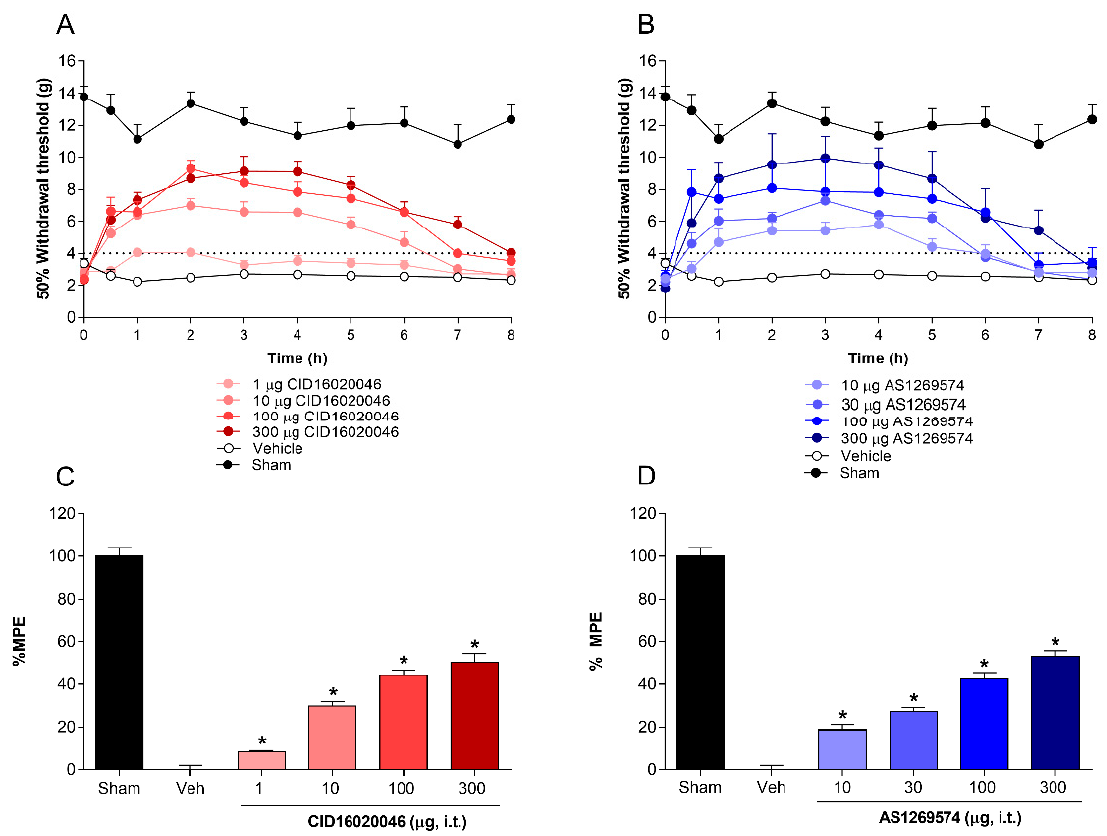
Figure 2. Antiallodynic effect of increasing doses of CID-16020046 (selective GPR55 antagonist; ( A , C )) and AS-1269574 (selective GPR119 agonist; ( B , D )) on tactile allodynia induced by L5-L6 spinal nerve ligation in rats. Data represent the mean ± SEM of six animals per group. * Significantly different from the vehicle group by one-way analysis of variance, followed by post hoc Dunnett’s test with p < 0.05. Abbreviations: %MPE = percentage of maximum effect possible.